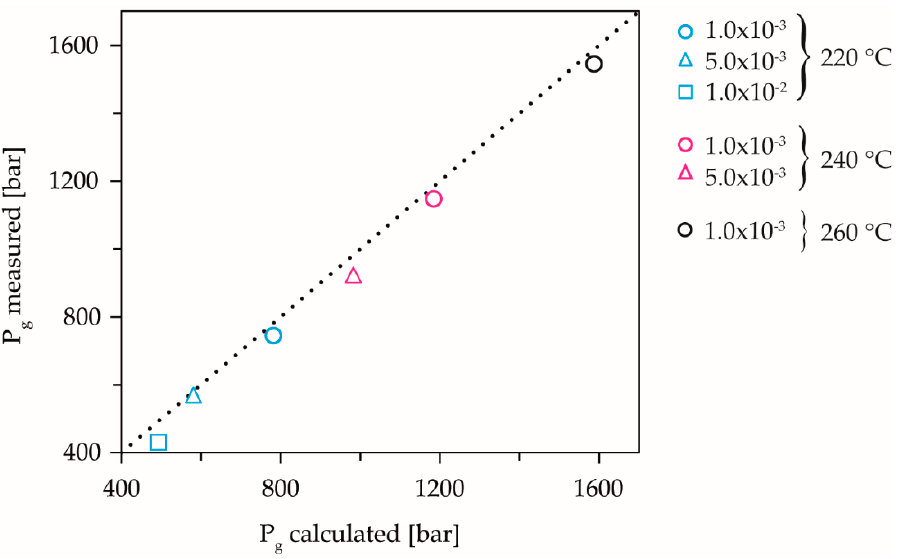
Figure 6. Validation of the calculation results by the performed limit experiments with evaluation according to Roth et al. [38]. Reprinted with permission from ref. [38]. Copyright 2020 Copyright Polymers.